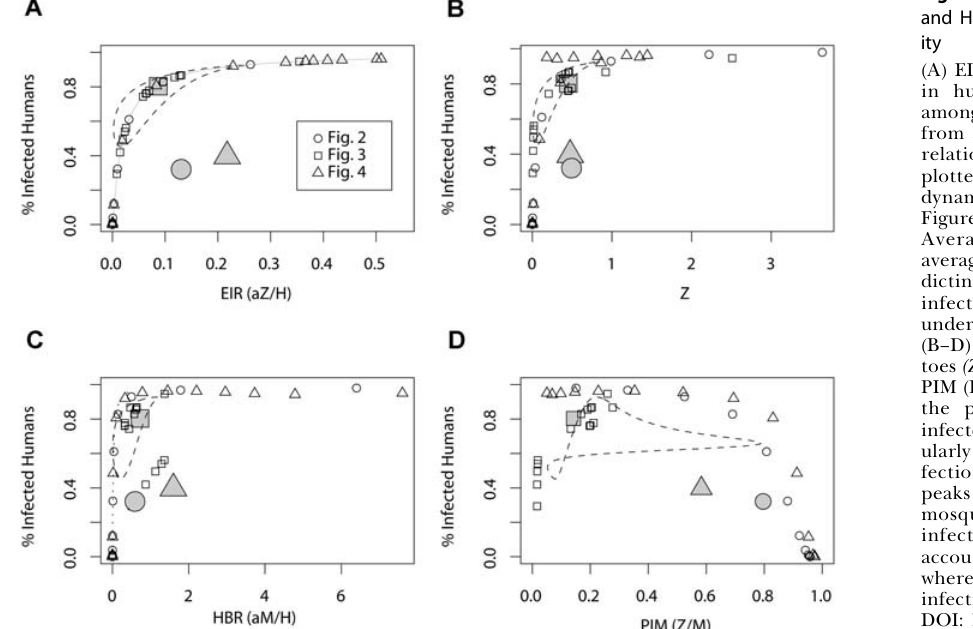
Figure 5. The Relationship between EIR and Human Prevalence, with Heterogene- ity (A) EIR and the prevalence of infection in humans have a tidy relationship among patches; each small symbol is from a single patch in Figures 2–4. The relationship, given by equation 1, is plotted in gray. The phase plane of the dynamic relationship over time from Figure 1 is plotted with dashed lines. Average EIR is plotted against the average prevalence (large symbols). Pre- dicting the average prevalence of human infection from average EIR leads to underestimates. (B–D) The density of infectious mosqui- toes (Z) (B), HBR (HBR = aM / H ) (C), and PIM (PIM = Z / M ) (D) are plotted against the proportion of humans who are infected and infectious. PIM is a partic- ularly bad measure of the risk of in- fection; in heterogeneous habitats, it peaks far from larval habitat, where mosquito density and prevalence of infection in humans is lowest. This accounts for the large number of points where PIM is high, but the proportion of infectious humans is low. DOI: